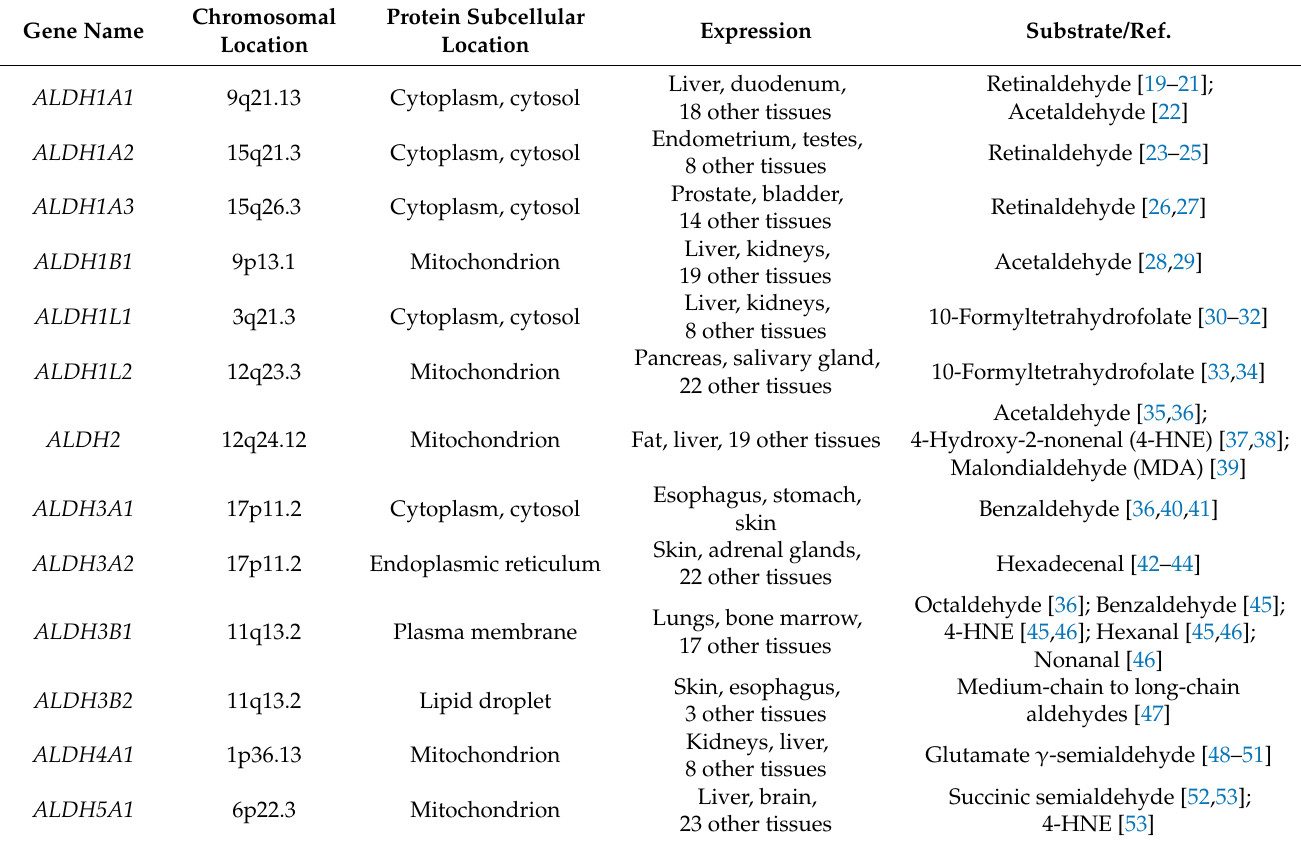
Table 1. Human aldehyde dehydrogenase (ALDH) gene